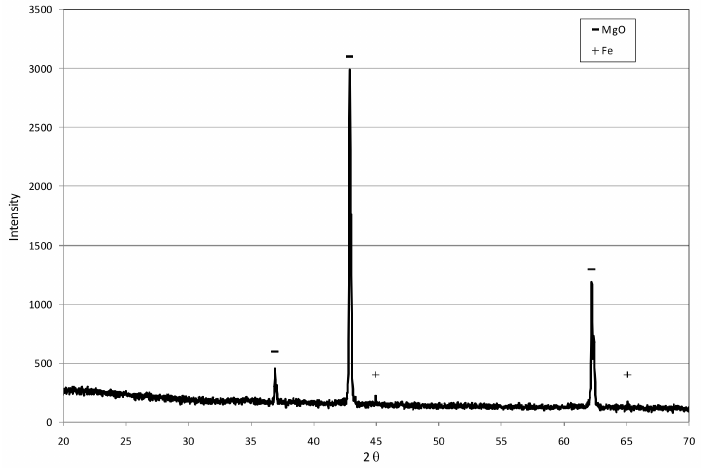
Figure 2. XRD diffractogram of MgO_nZVI particles.